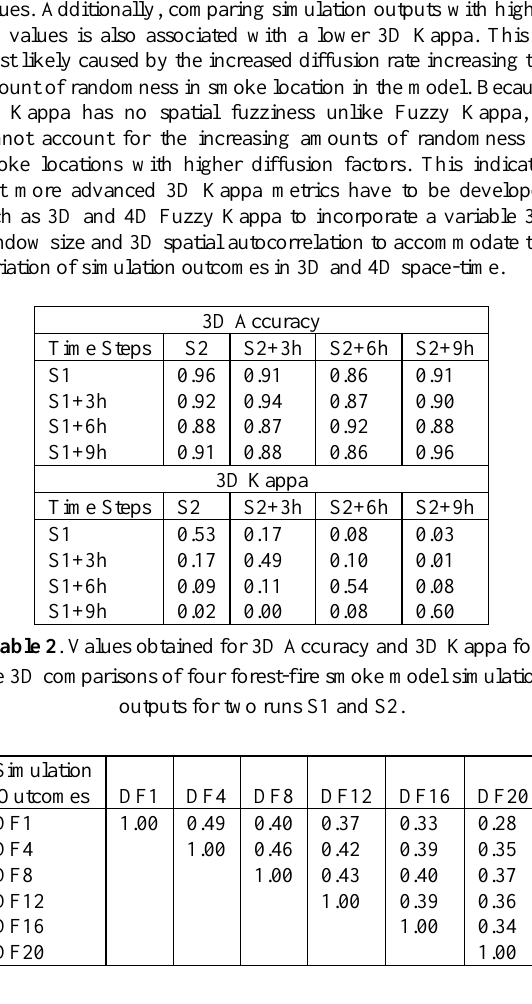
Table 3 . Values obtained for 3D Kappa for the comparisons of the forest-fire smoke propagation model simulation outputs